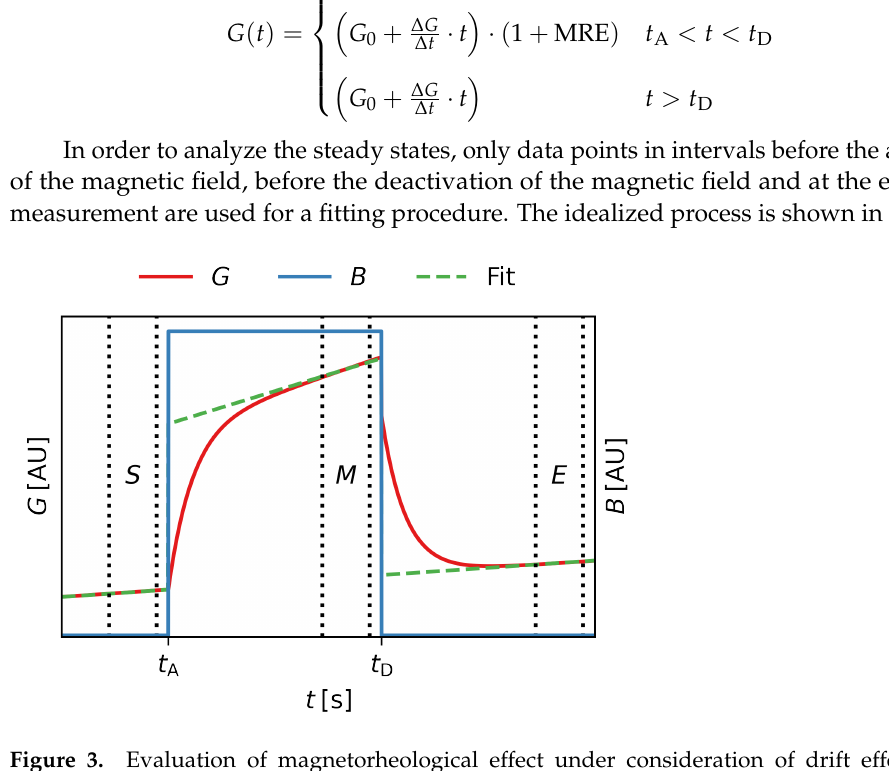
Figure 3. Evaluation of magnetorheological effect under consideration of drift effects using Equation (2) with idealized data. Only data points in the intervals S, M, und E are used for re- gression